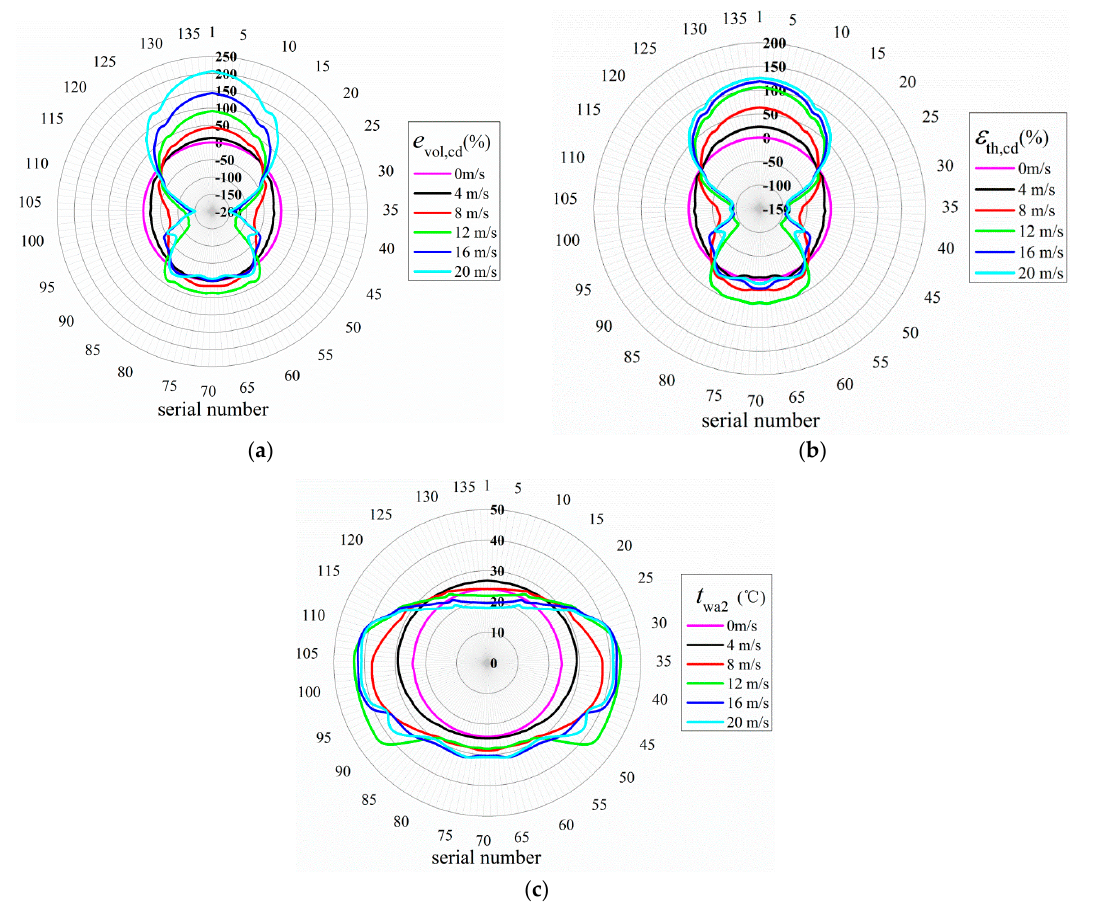
Figure 13. Performance distributions for case B. ( a ) Volume effectiveness; ( b ) Thermal efficiency; ( c ) Outlet water temperature.